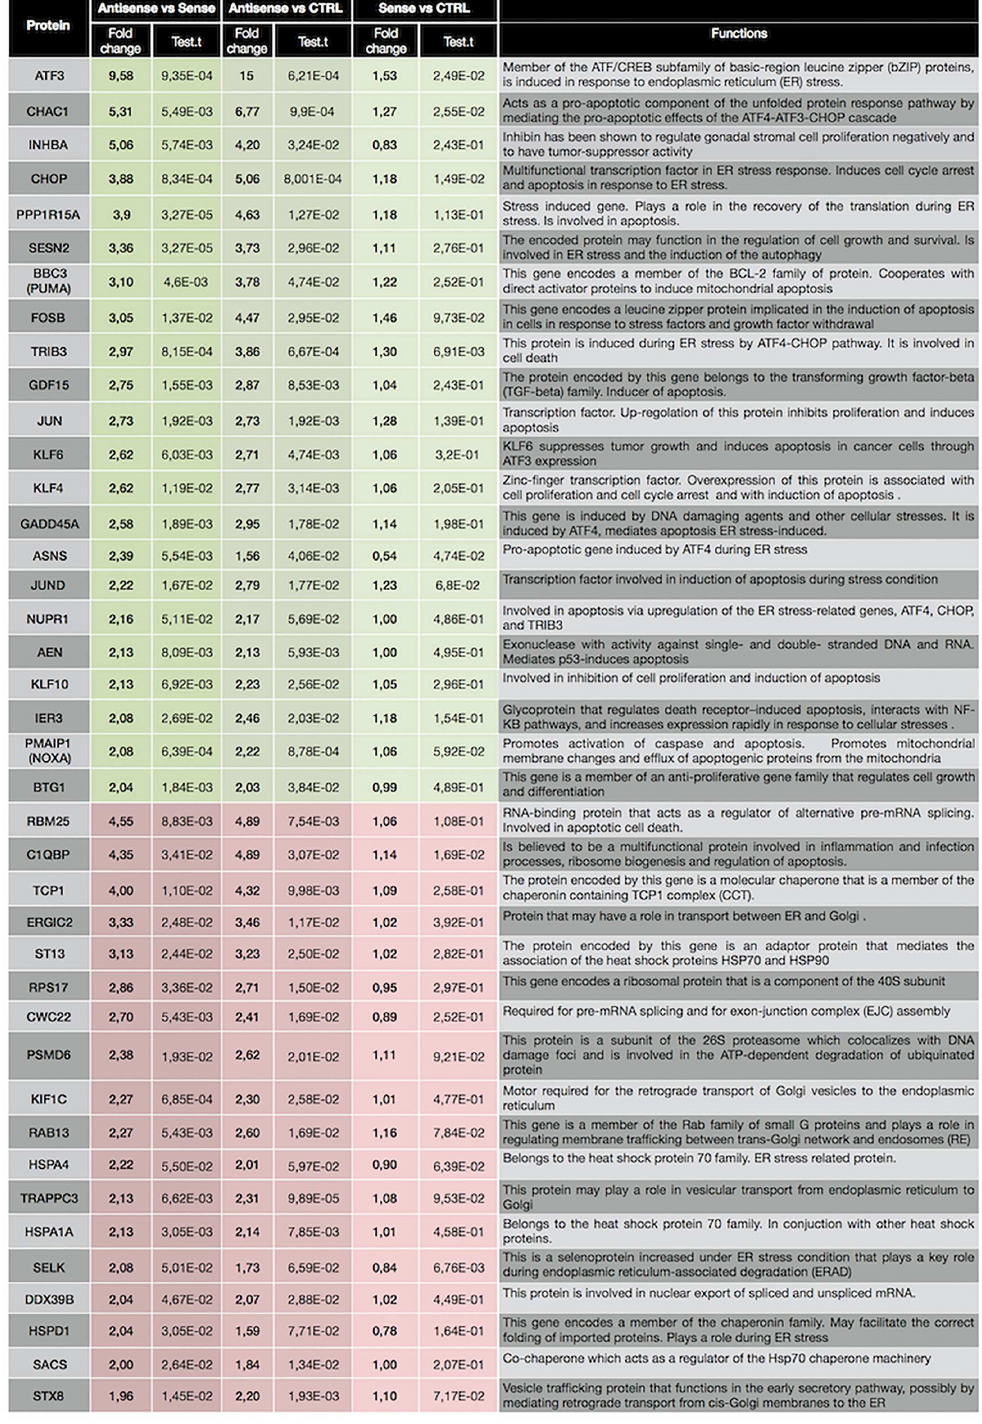
Fig 3. Filtered list of genes which showed a fold change > 2 (ASO vs SO) in the microarrayanalysis at 6h, and belonged to the top GO terms listed in Table 1.